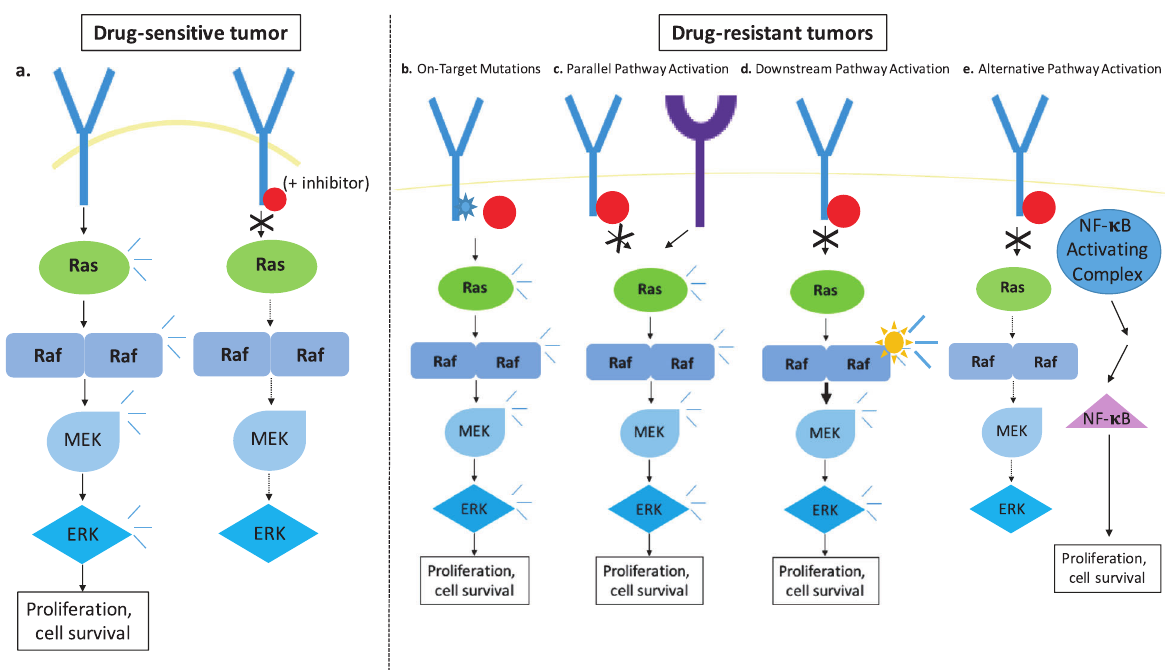
Fig. 1 Mechanisms of resistance to targeted therapies. a . Example of a drug-sensitive tumor. Downstream signaling is decreased upon addition of a targeted inhibitor. b – e . Examples of mechanisms promoting drug-resistant tumors. b . On-target mutations block the ability of the drug to bind to and inhibit the target oncoprotein, allowing continued signaling to promote tumor survival. c . Upregulation of a distinct receptor tyrosine kinase sustains signaling through a critical signaling pathway despite continued inhibition of the primary oncoprotein with the targeted drug. d . Mutational activation of a protein involved in a critical downstream signaling pathway reactivates the pathway below the level of inhibitor blockade. e . Activation of pro-survival signaling networks can prevent inhibitor-mediated